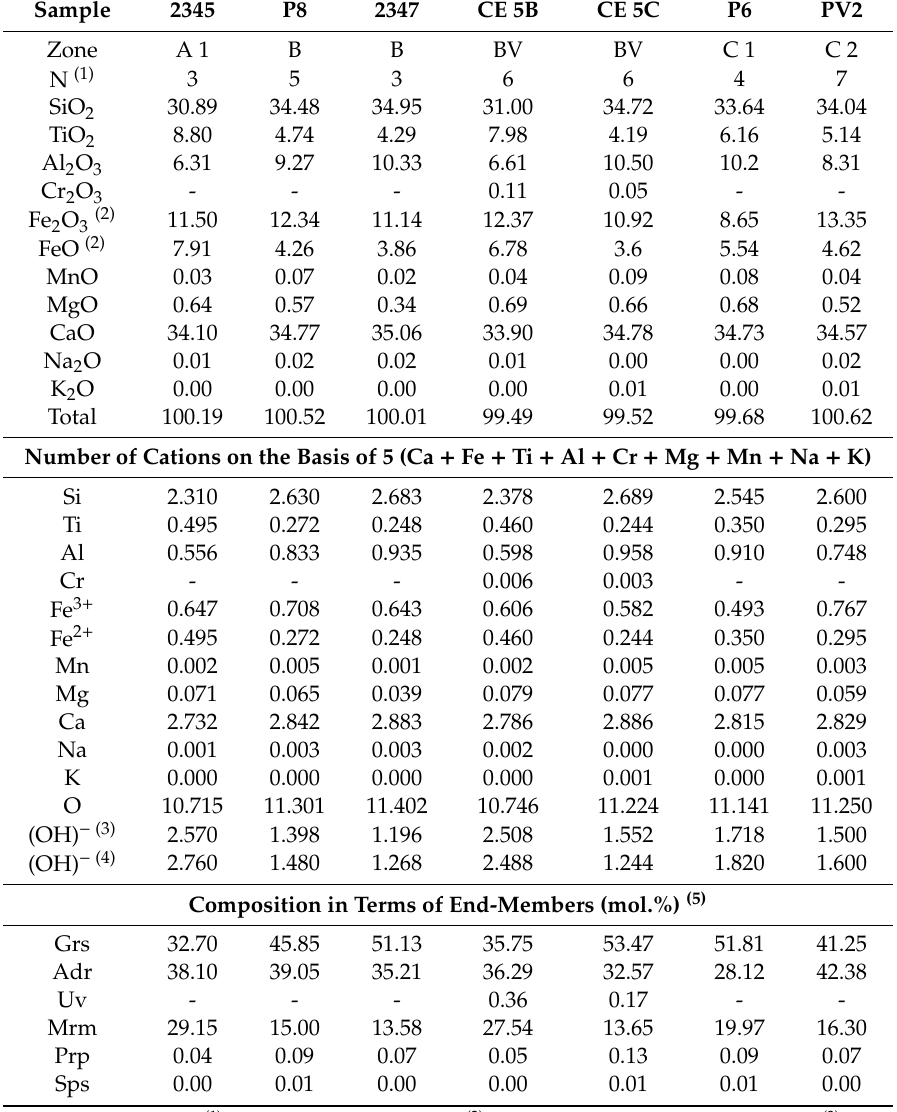
Table 5. Representative compositions of Ti-rich garnets (grossular II and Ti-andradite), M ă gureaua Va¸tei